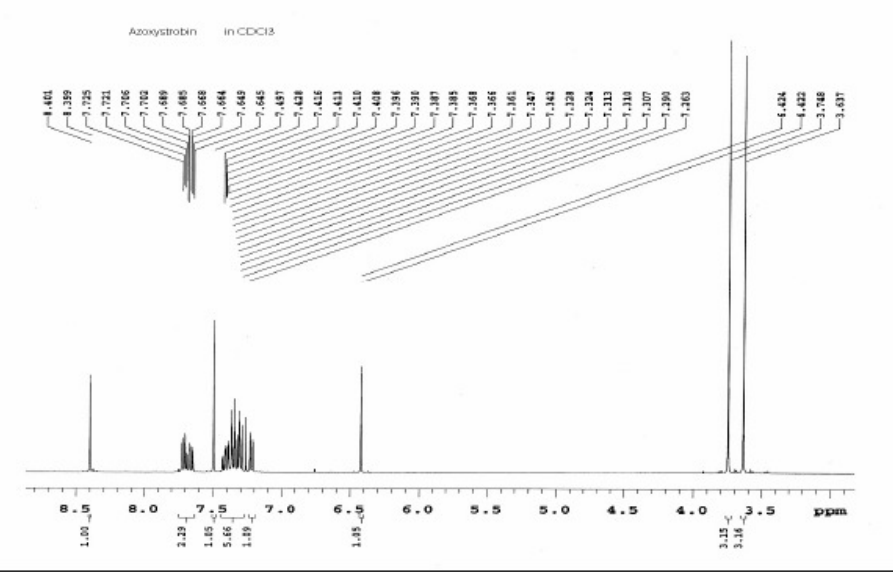
Figure 4. 1 H NMR spectrum of